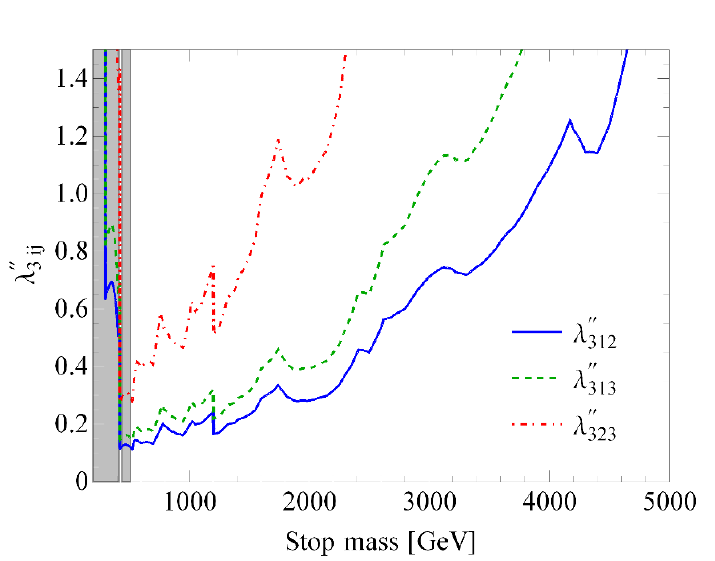
Figure 6. Exclusion plot for a LSP stop. The area above each curve is excluded by dijet searches. Additionally, the grey area is excluded by stop pair production with subsequent decay into four quarks. As explained in the text, it applies equally to all (cid:21) 00 3 ij